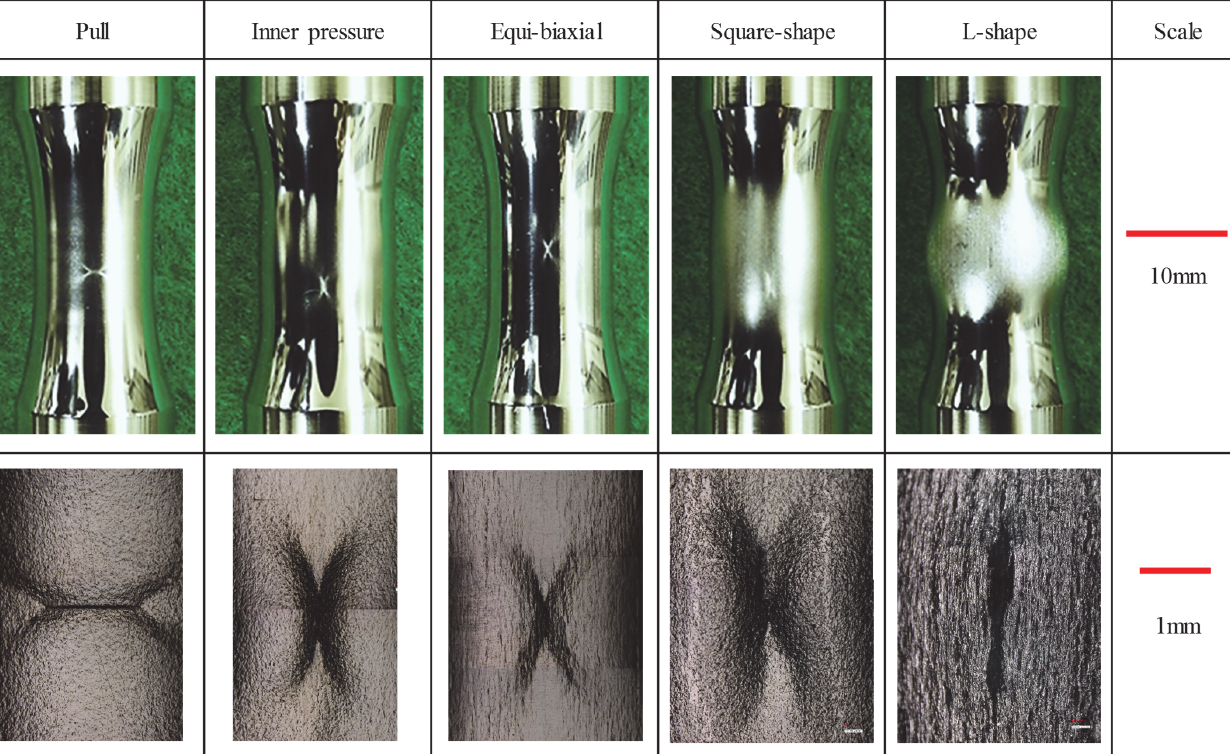
Figure 9: Specimen surface and crack